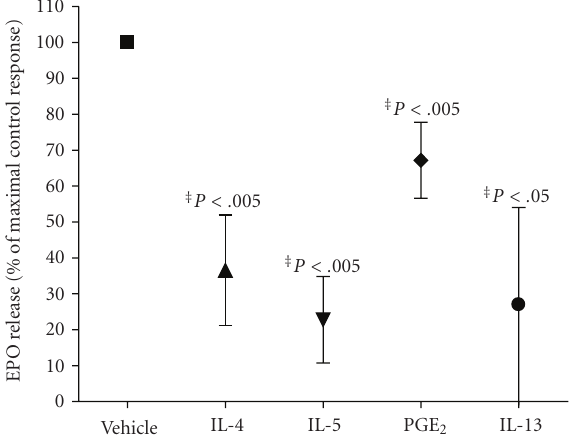
Figure 6: Th2 cytokines and PGE 2 inhibit eosinophil degranu- lation. Purified human eosinophils were pretreated with vehicle, IL-4 (10ng/mL), IL-5 (10ng/mL), IL-13 (10ng/mL), and PGE 2 (10 − 6 M) for 1 or 2 hours and then stimulated with C5a (300nM) for 30min at 37 ◦ C. The release of EPO activity into supernatants wasdetermined by photometry. Data were expressed asa percentage of the maximal control response (300nM) and are shown as the mean ± SD; n = 5–9; ∗∗ P < . 005, ∗ P < . 05 versus C5a alone